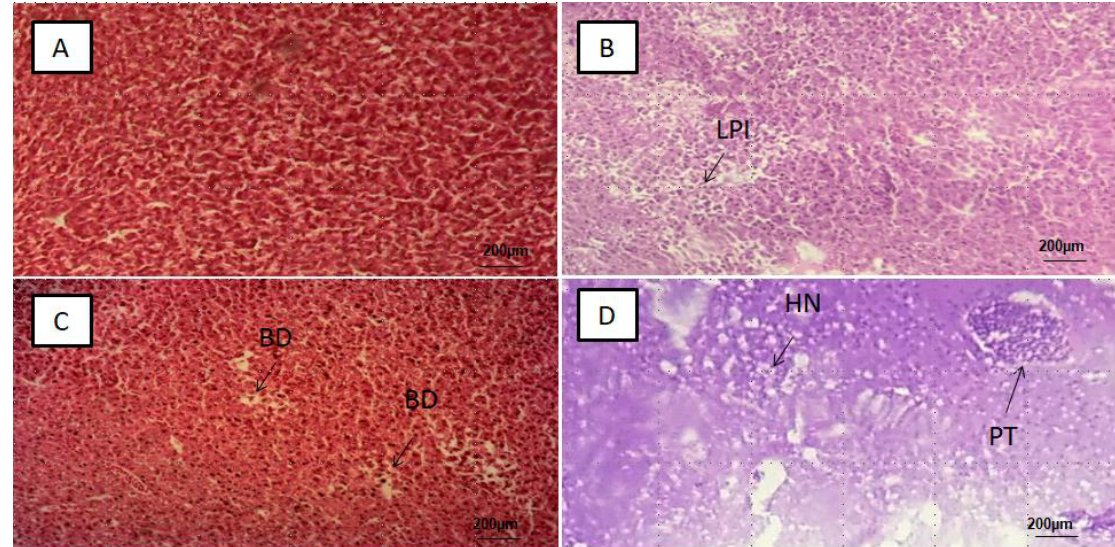
Figure 3. Representative photomicrograph of liver tissue: ( A ) Control group with normal liver tissue, ( B ) MP-LOW group showing liver parenchymal inflammation (LPI), ( C ) MP-MED group showing ballooning degeneration of hepatocytes (BD), and ( D ) MP-HIGH group showing hepatic necrosis (HN) and portal triaditis (TN).